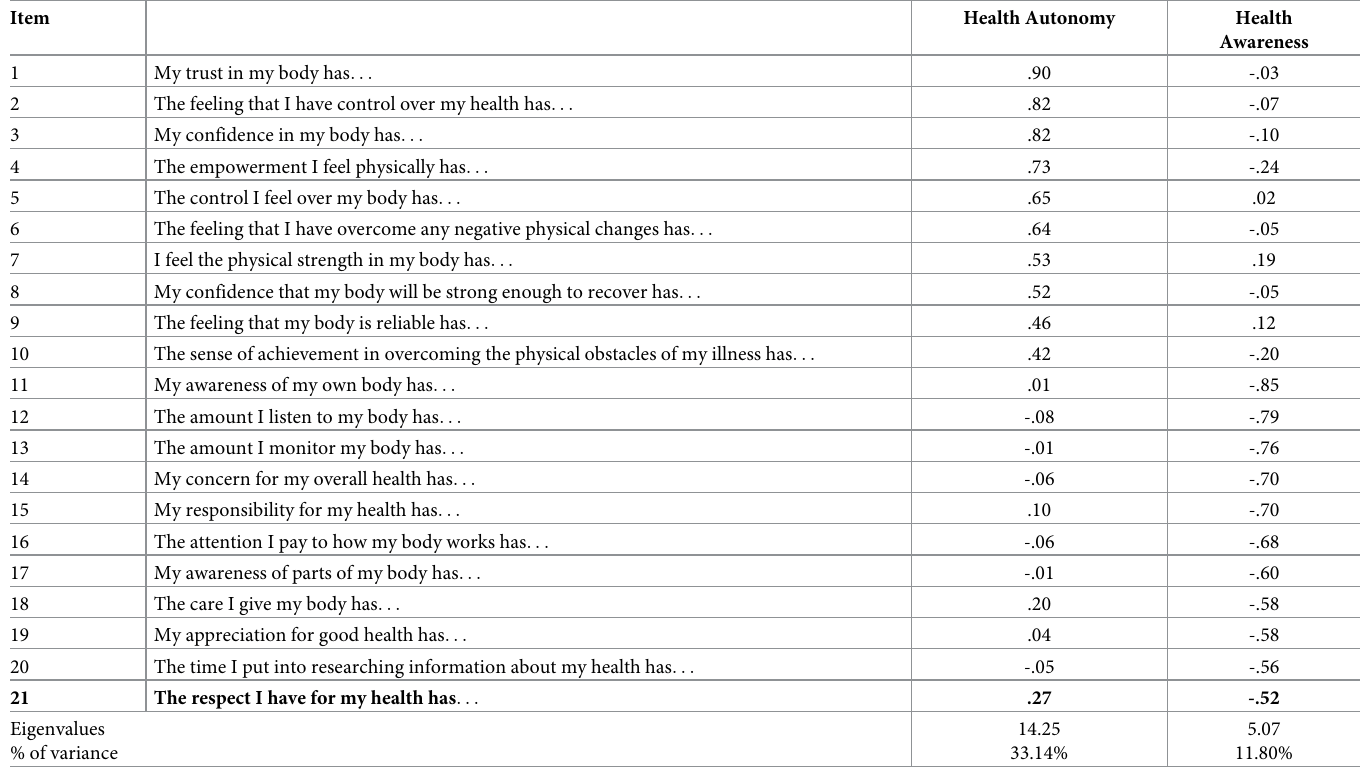
Table 2. Factor loadings for principal axis factor analysis of the P-PTGI. Item Health Autonomy Health